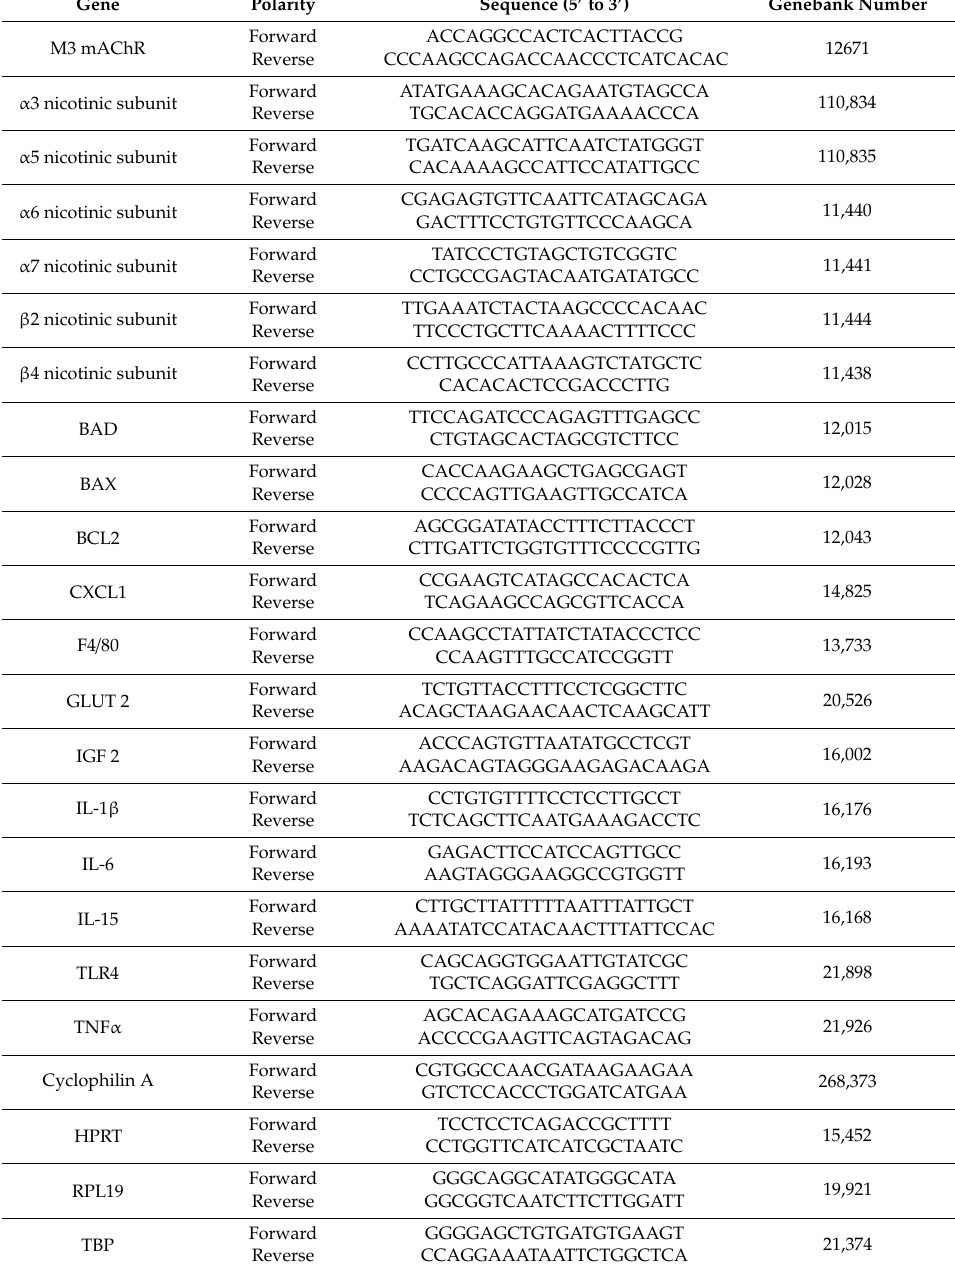
Table 2. Genes analyzed by Real-Time PCR and primer